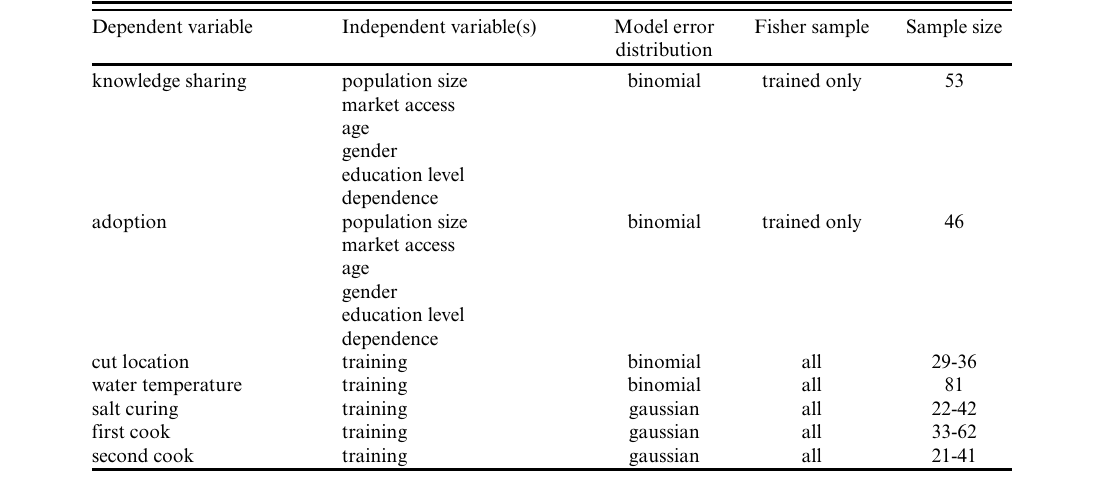
Table 2 . Summary of Bayesian hierarchical linear